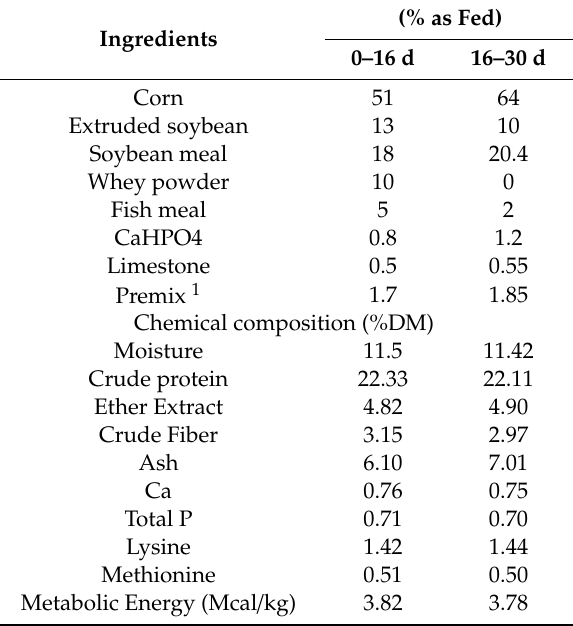
Table 1. Composition and nutrient levels of basal diets (air-dry basis).